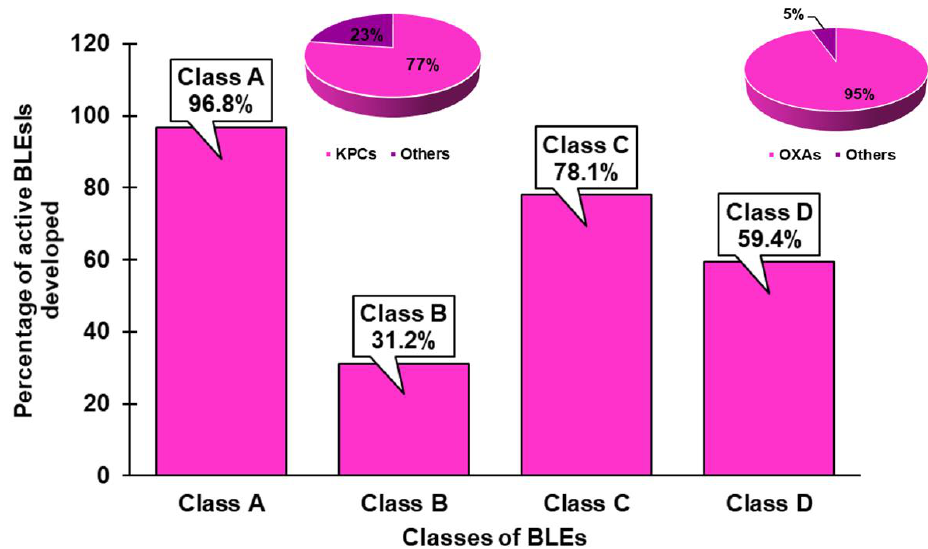
Figure 9. Percentages of all developed BLEsIs active on the different classes of BLEs.